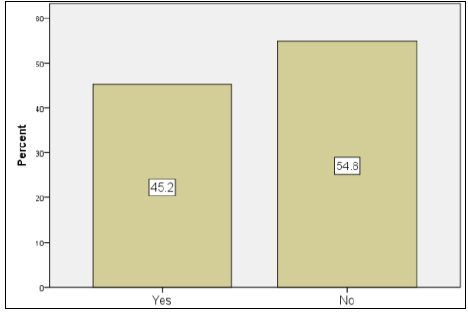
Figure 4: Knowledge of HACCP or Any Other Food Safety Standards; Source: Author Implementations of Continuing Education Courses on HACCP and Food